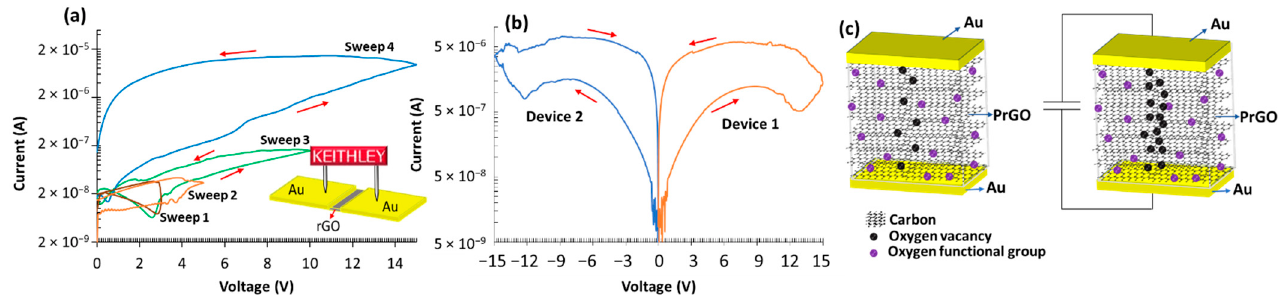
Figure 5. ( a ) I-V curves for 4 h rGO device generated by the parameter analyzer, multiple voltage sweeps are visible from 3 V to 15 V. ( b ) the I-V curve for two devices at ∓ 15 V sweeps, the hysteresis curve is mirrored, indicating unipolar switching. ( c ) A schematic of the switching mechanism takes place in the devices in ( a , b ), the GO layers are reduced by Joule heating, each subsequent sweep further reduces the GO flakes.